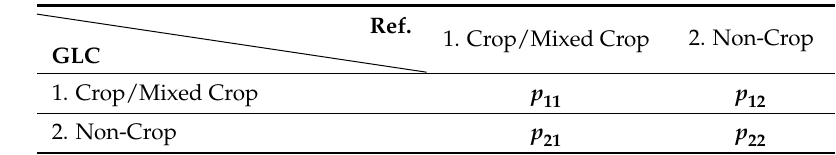
Table 3. Population confusion matrix for two aggregated land cover types (i.e., global land cover (GLC) group